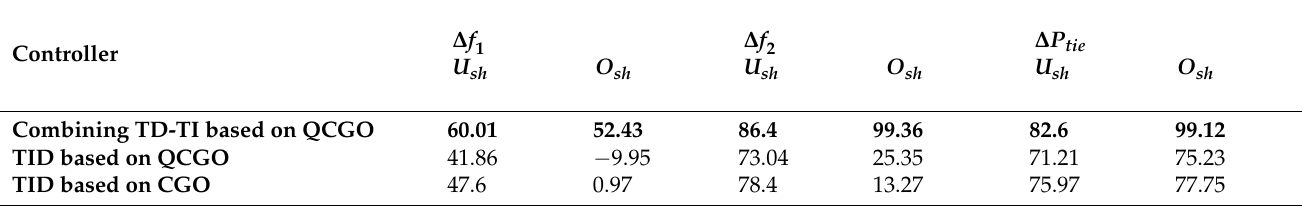
Table 11. Percentage improvement in U sh and O sh values for combining TD-TI/QCGO and PID/AOA based on PID controller via TLBO for scenario